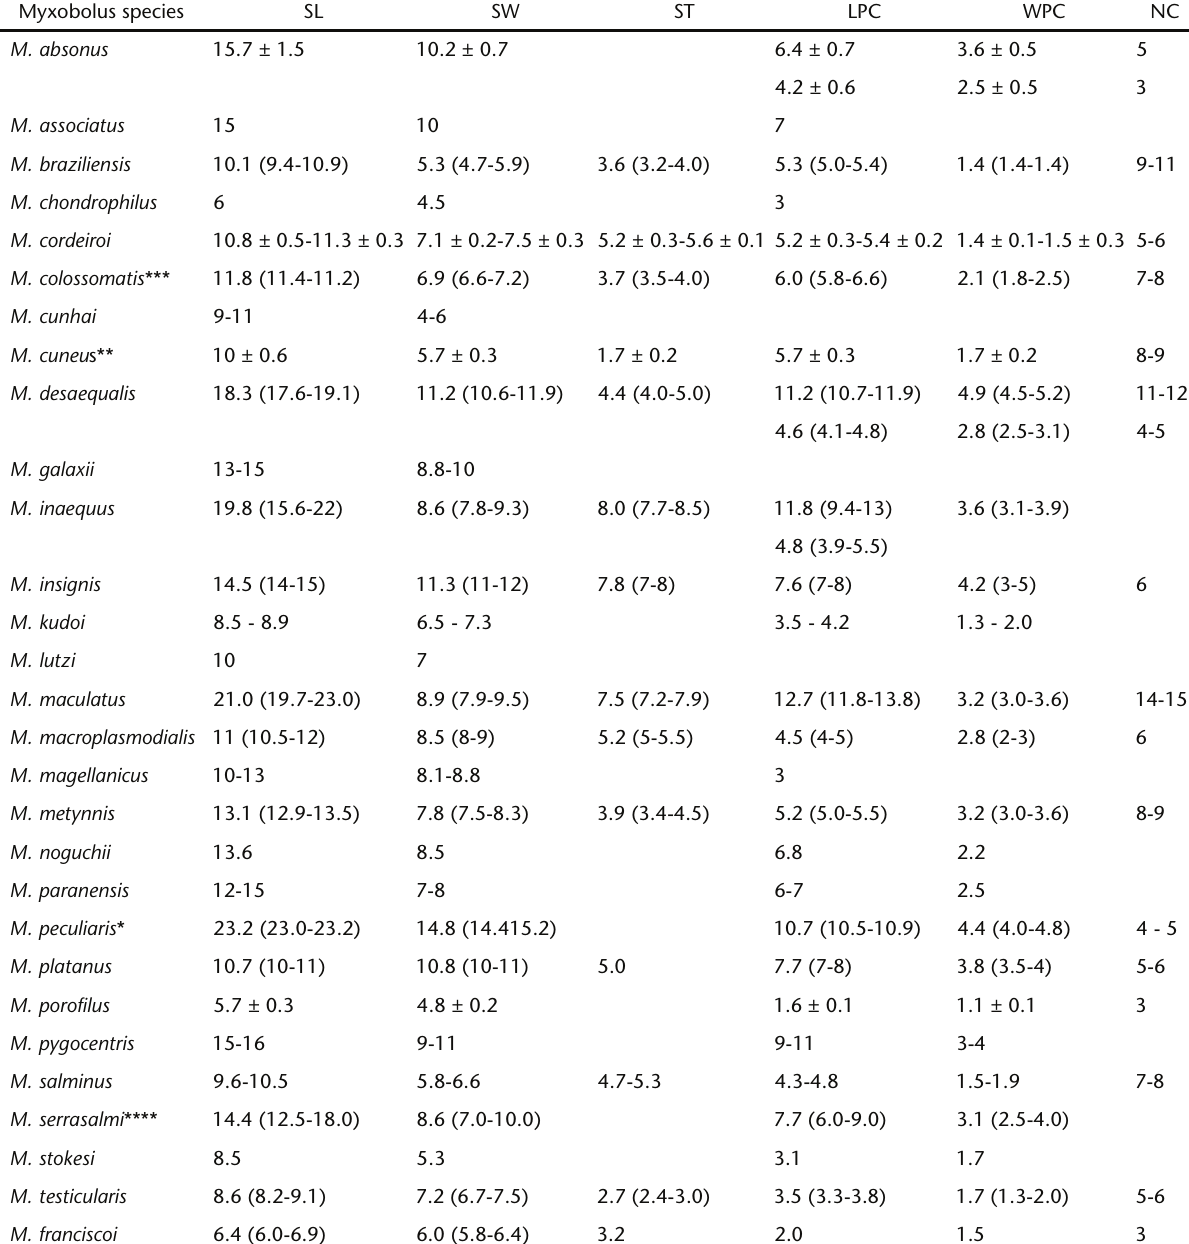
Table I. Features (measurements in µm) of the valid Myxobolus species described from South American fishes. (SL) Body spore length, (SW) body spore width, (ST) body spore thickness, (LPC) length of the polar capsules, (WPC) width of the polar capsules, (NC) number of coils of the polar filament.